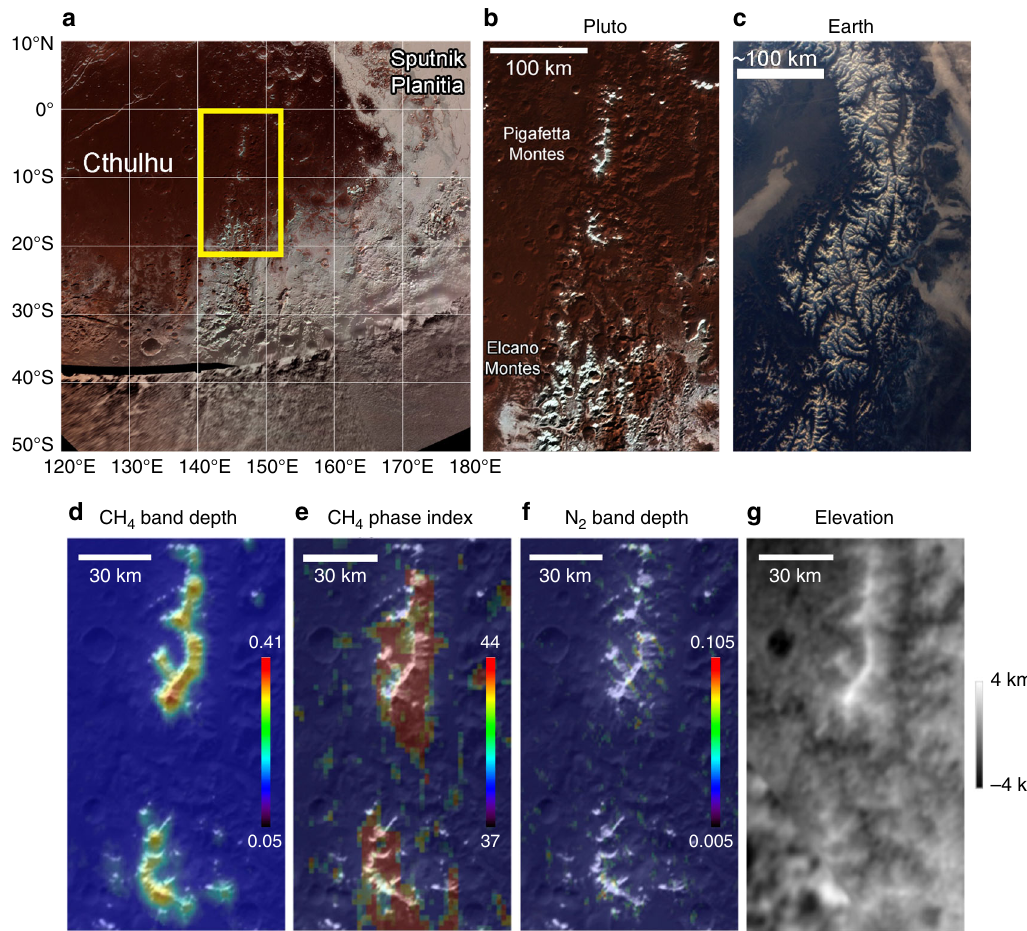
Fig. 1 Detection of CH 4 -rich ice on top of Pigafetta and Elcano Montes. a New Horizons map of the southeast Cthulhu region on Pluto, located in the equatorial regions west of Sputnik Planitia. Yellow box indicates the boundaries of the area seen in detail in ( b ). b Detail of the CH 4 frost-capped ridges of Pigafetta and Elcano Montes within Cthulhu Macula (148.2°E, 10.1°S), seen in an enhanced Ralph/MVIC colour image (680 m/pixel, cylindrical projection). c Satellite view of water ice-capped mountain chains in the Alps. d LEISA CH 4 band depth map focusing on the Pigafetta Montes within Cthulhu, superimposed on the visible map, with blue-to-red indicating increasing CH 4 absorption. e CH 4 phase index map (at ~3× lower spatial resolution, see de fi nition in ‘ Methods ’ , Phase index maps), with red corresponding to CH 4 -rich ice and green-blue to N 2 -rich ice containing CH 4 . Yellow corresponds to some mixture of both phases. The high value of the CH 4 -phase index likely indicates that only the CH 4 -rich phase is present. f Same as ( d ) for the N 2 band depth map. g New Horizons elevation map. Lateral resolution of the topography data at Pigafetta Montes is ~2.5 km, with a vertical precision of 230 m 11